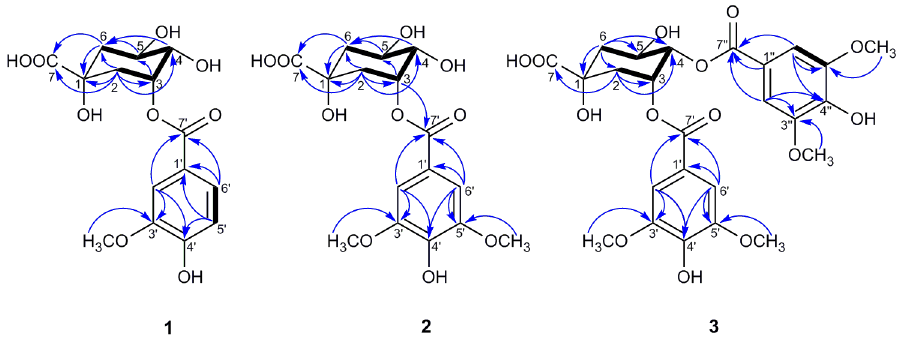
Figure 3. Key HMBC ( → ) and 1H–1H COSY ( ) correlations of compounds 1 – 3 . Table 2. 1 H NMR and 13 C NMR spectroscopic data of the new compounds 1 – 3 a .